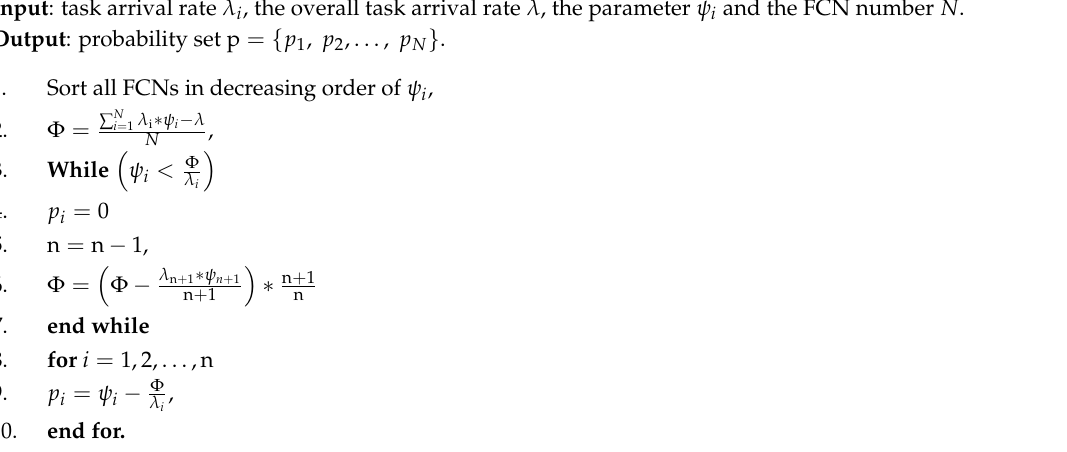
Algorithm 1: post-processing algorithm for eliminating the negative p i